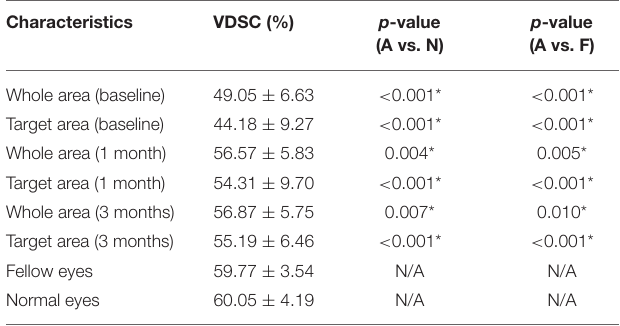
TABLE 3 | Comparisons of affected eyes, fellow eyes, and normal control at